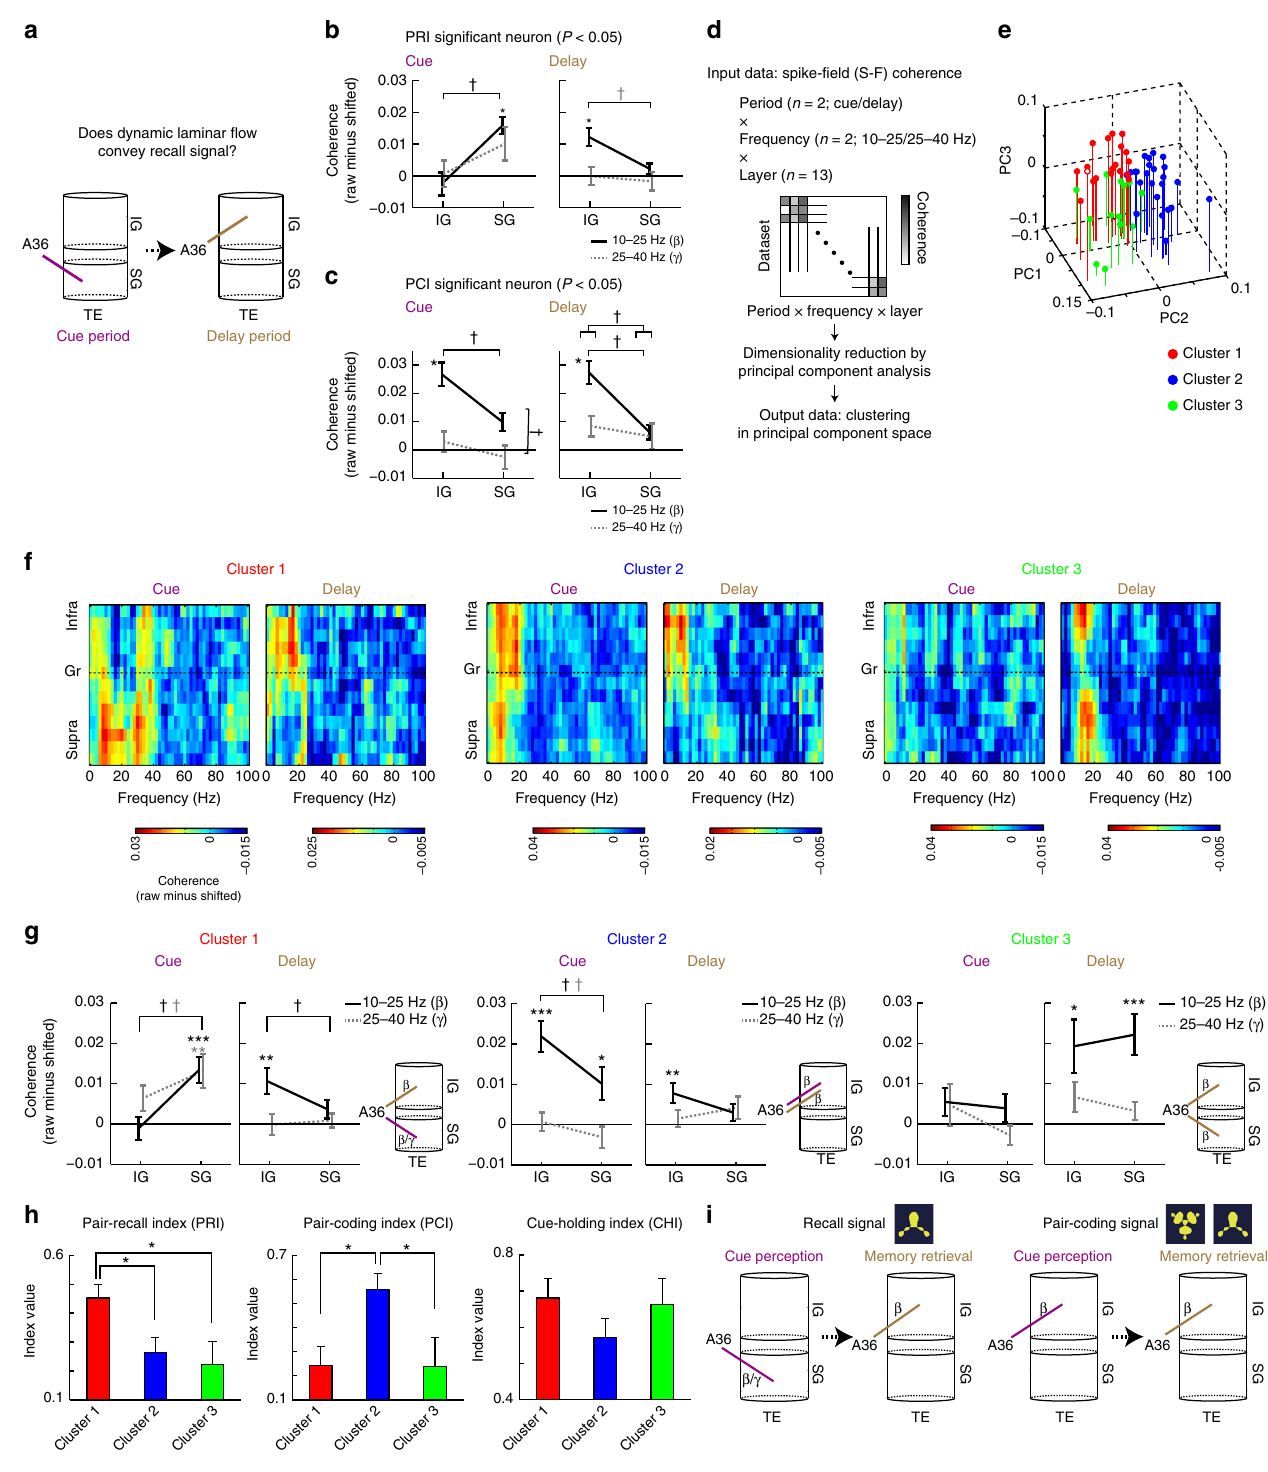
determining the optimal number of clusters, we found three clusters showing distinct transition of the layer speci fi city of coherence from the cue to the delay periods (Fig. 3e − g; Supplementary Fig. 5c − d, 6, 7 and 8; see Supplementary Fig. 9 for individual coherence pro fi les; see Methods for details). The three clusters depicted signi fi cantly different patterns of coher- ence pro fi les [four-way ANOVA for clusters (1 − 3), layers (IG/ SG), periods (cue/delay), and frequencies (10 − 25/25 − 40): F = 3.48, P = 0.0381 for interaction between clusters and layers; F =